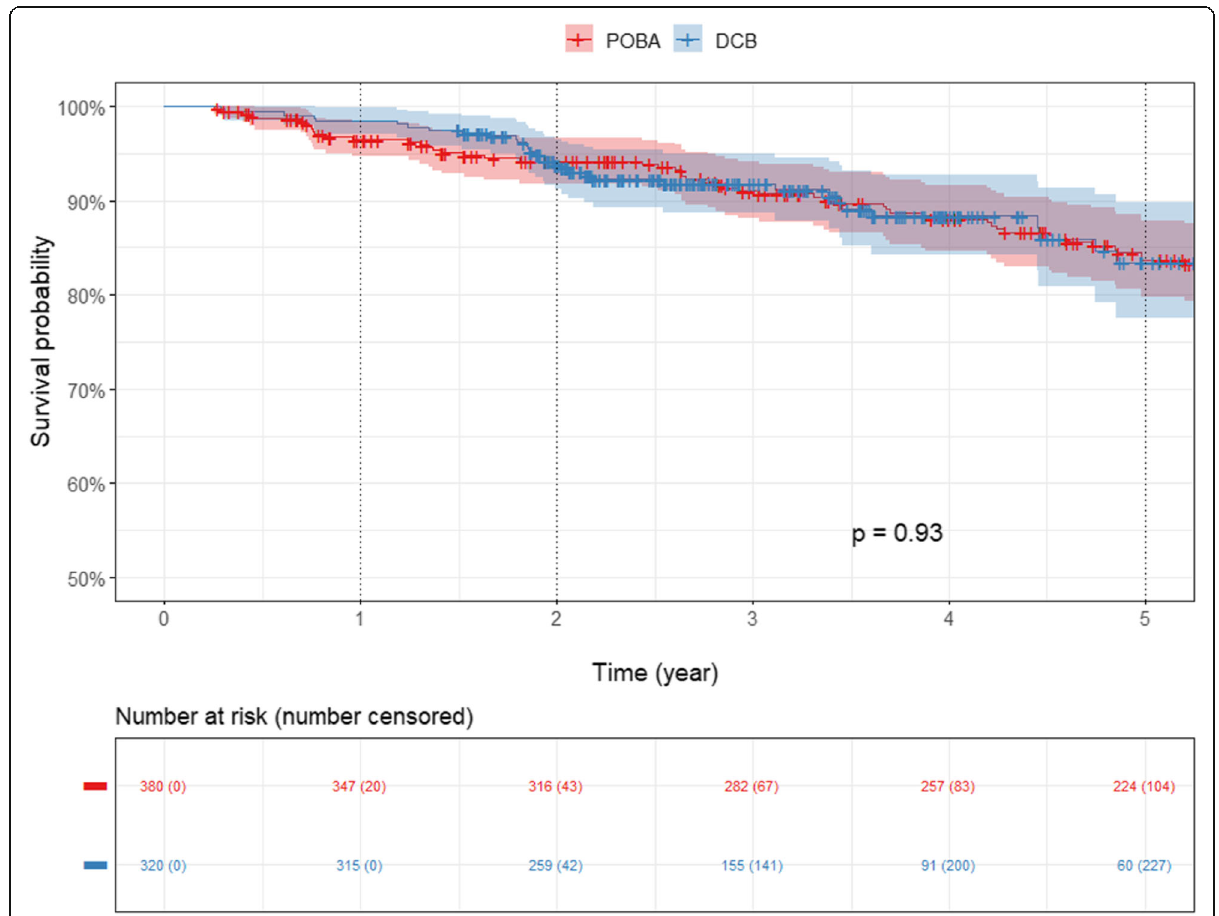
Fig. 2 Kaplan-Meier estimates of survival of the entire cohort for the POBA and DCB group through 5 years including the interval of confidence. (PCD: Paclitaxel Coated Devices; POBA: Plain Old Balloon